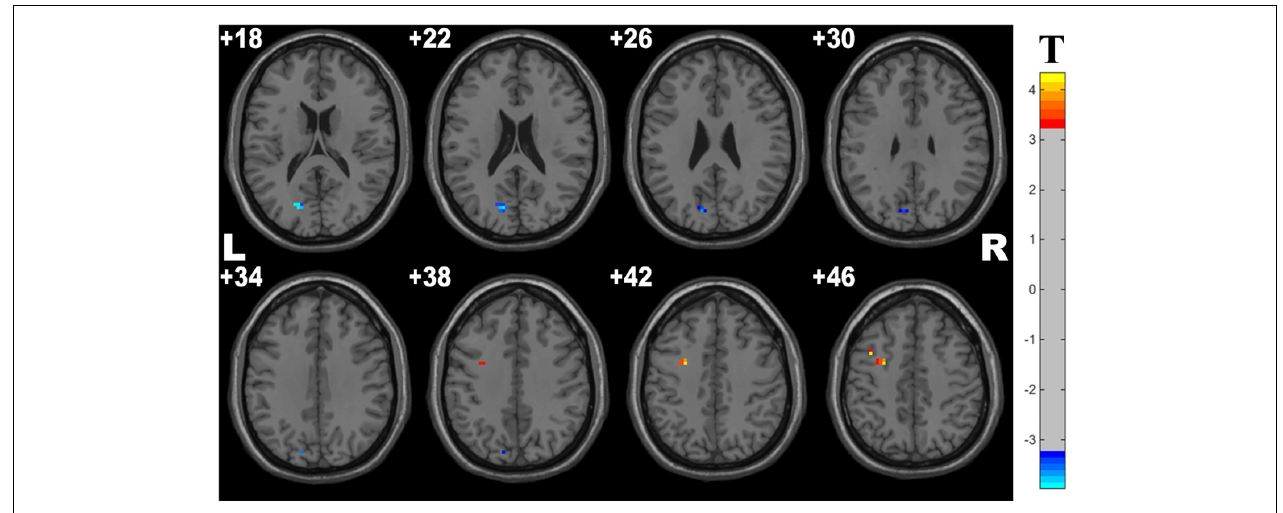
FIGURE 2 | Cluster with significantly altered fALFF in OSA children compared with controls (with GRF correction, voxel level p < 0.001, cluster level p < 0.05). The blue and red areas denote higher and lower fALFF in OSA group. TABLE 4 | Two-sample t -tests demonstrated regions with significantly decreased ReHo in OSA children compared with controls (with GRF correction, voxel level p < 0.001, cluster level p < 0.05). Condition